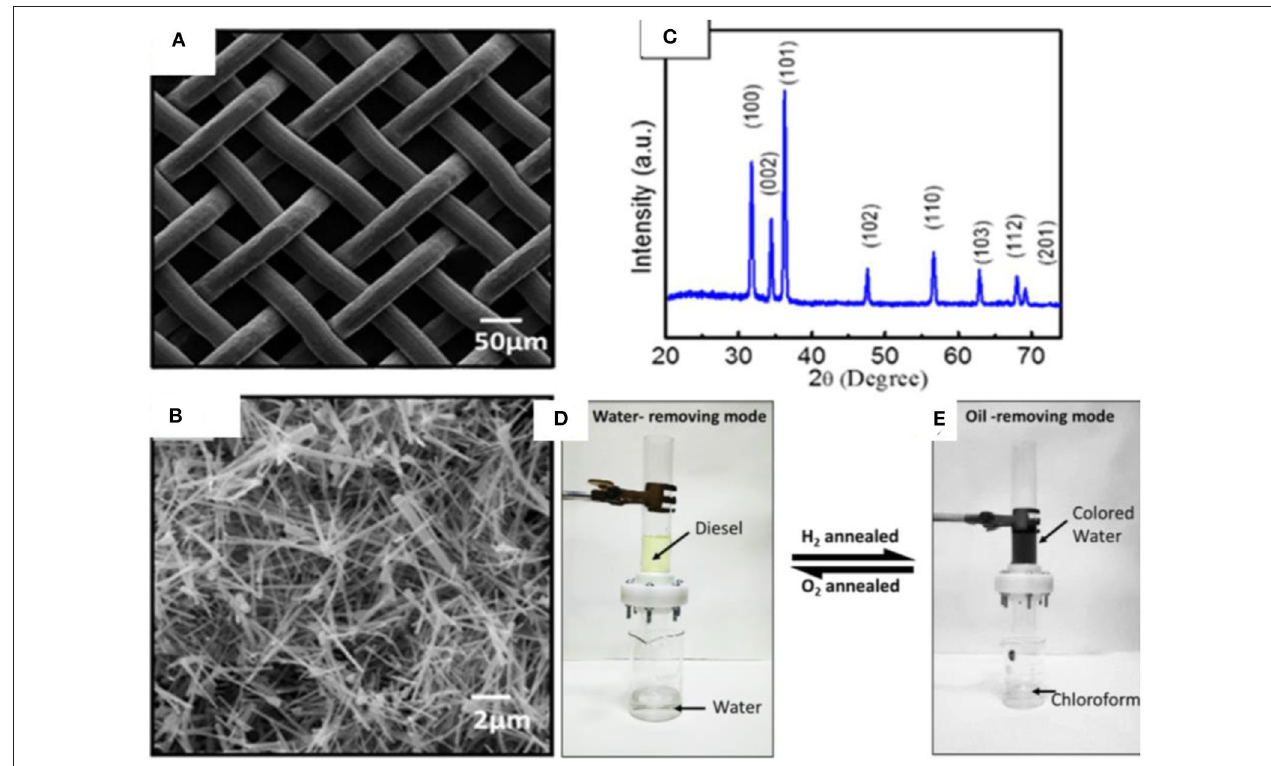
FIGURE 15 | (A,B) SEM images showing the structure of pristine and ZnO-coated mesh. (C) X-ray diffraction (XRD) pattern of ZnO-coated mesh. (D,E) The separation device used for the separation of oil/water mixtures by using ZnO-coated mesh. Adapted from Raturi et al. (2017). With permission from the